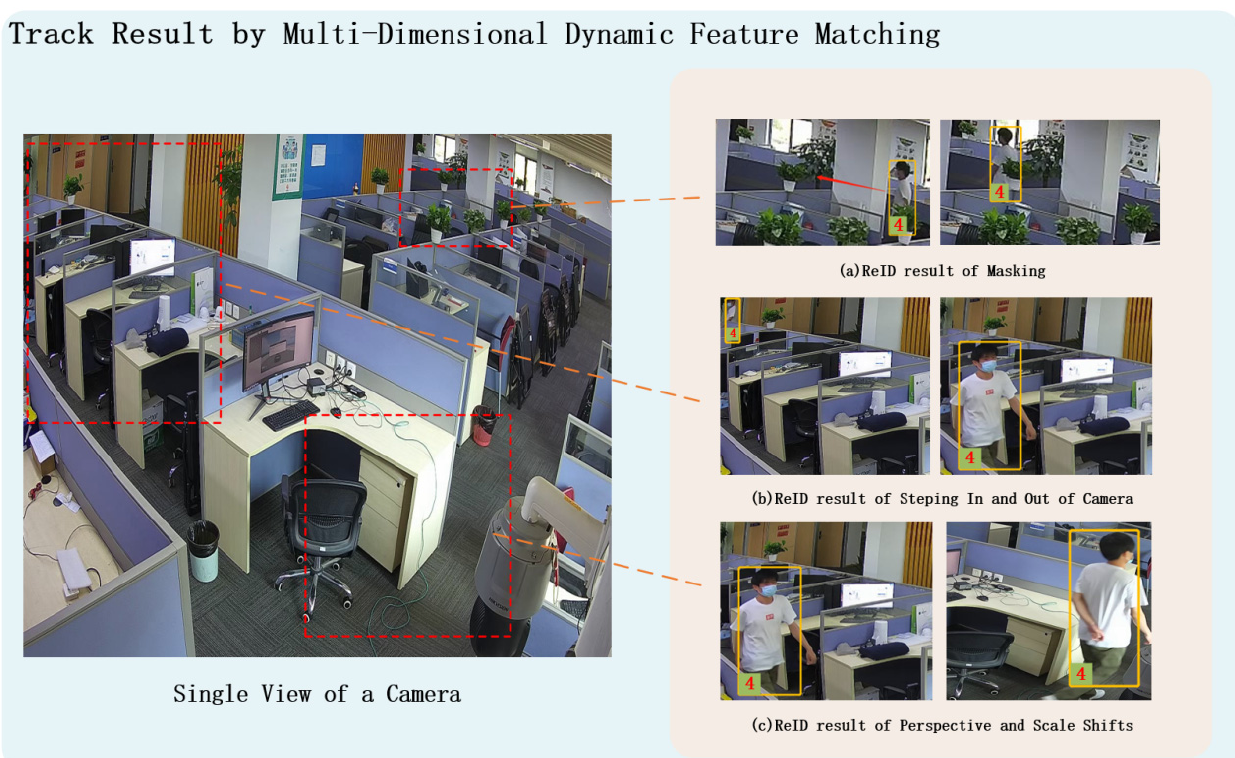
Figure 13. Graph of results after adding multi-dimensional dynamic feature